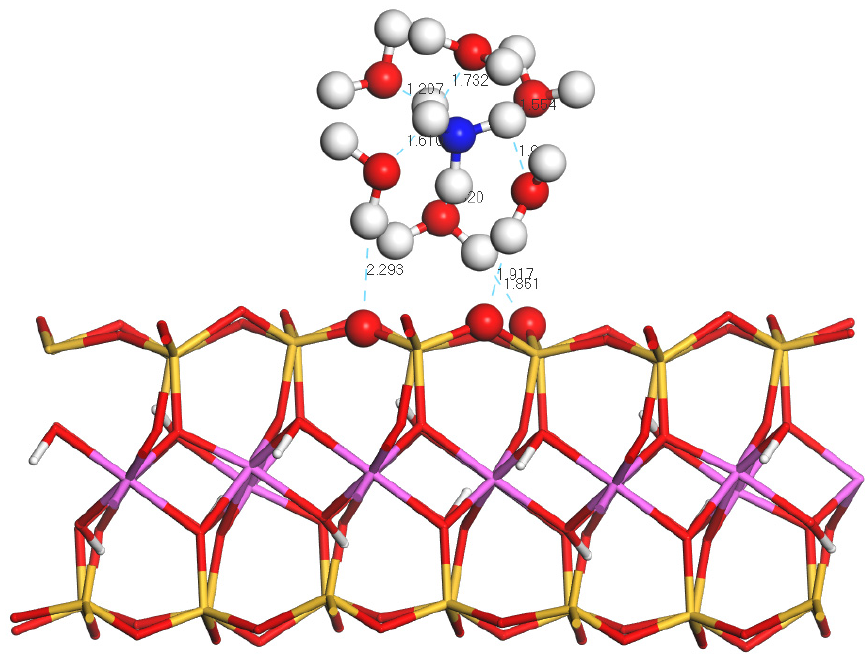
Figure 7. Equilibrium geometry of hydrated NH 4+ adsorbed on the (001) surface of Mt. The PDOSs of NH 4+ and the (001) surface before and after the adsorption are shown in Figure 8. Since there were no coordination bonds between the NH 4+ ion and H 2 O, the PDOS of the NH 4+ ion showed almost no change after the adsorption. In contrast, the PDOS of the surface shifted towards the lower energy direction, and its 2s and 2p orbitals were obviously far away from the Fermi level. The change in PDOS indicated that the system became more stable after the adsorption. The Mulliken charge of N is listed in Table 7. Similar to the slight change in the PDOS, the electron transfer of the N atom was very low, and its 2s and 2p orbitals only obtained 0.01 e and 0.05 e, respectively. The N atom obtained 0.06 e, and the charge decreased from − 0.79 to − 0.81 after the adsorption.